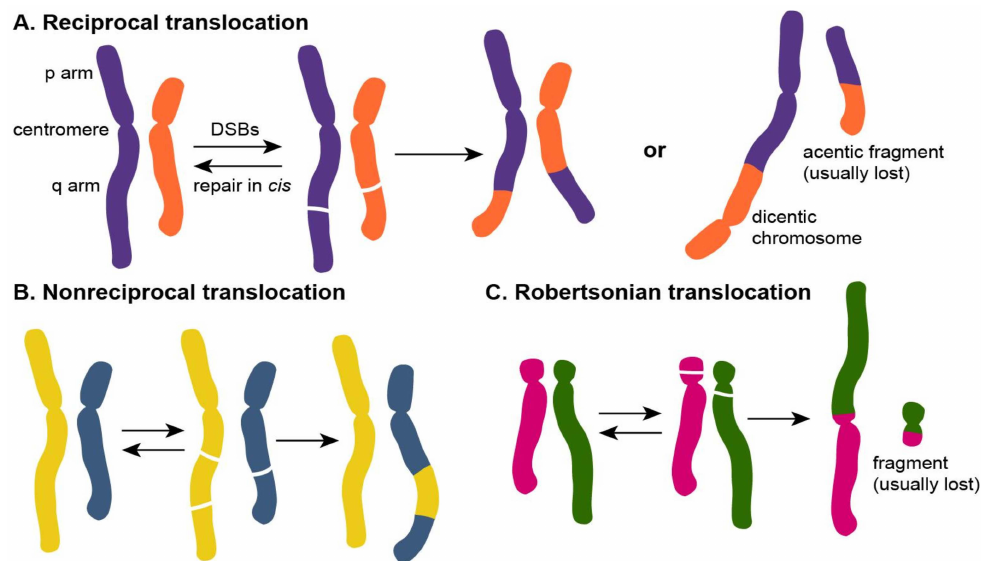
Figure 1. Types of chromosomal translocations. The illegitimate repair of the two DSBs in two non-homologous chromosomes can produce ( A ) reciprocal translocations if the exchange between two translocating chromosomes is bidirectional or ( B ) non-reciprocal translocations if the exchange is unidirectional. ( C ) Robertsonian translocations occur between two acrocentric chromosomes that are fused at the